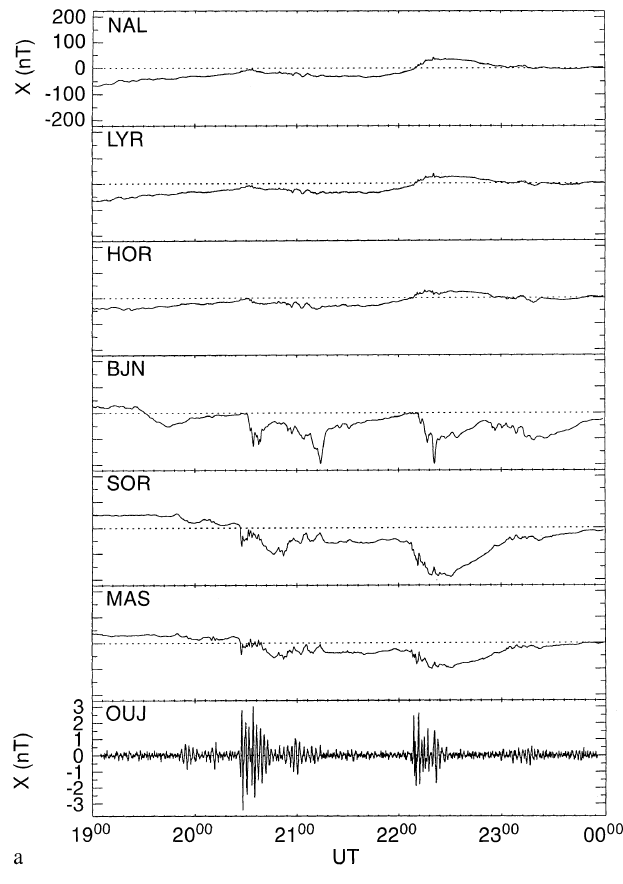
Fig. 2a,b. Ground magnetograms from the IMAGE array a X components, b Z components. A subset of the IMAGE array, forming a meridional chain from Svalbard to northern Scandinavia, is